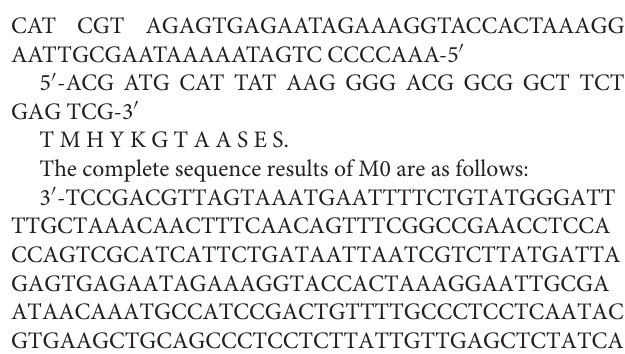
FIGURE 2 | The identification results of CD44 + /CD24 − / low with flow cytometry. (A) The proportion of CD44 + /CD24 − / low for ordinary MDA-MB-231 was nearly zero. (B) The proportion of CD44 + /CD24 − / low for MDA-MB-231 breast cancer stem cell was 70.5%. ESA APC, epithelial surface antigen allophycocyanin; FSC, forward scatter; P1, breast cancer stem cell; P2, CD44 + cells; PE, phycoerythrin; SSC, side scatter. CAT CGT